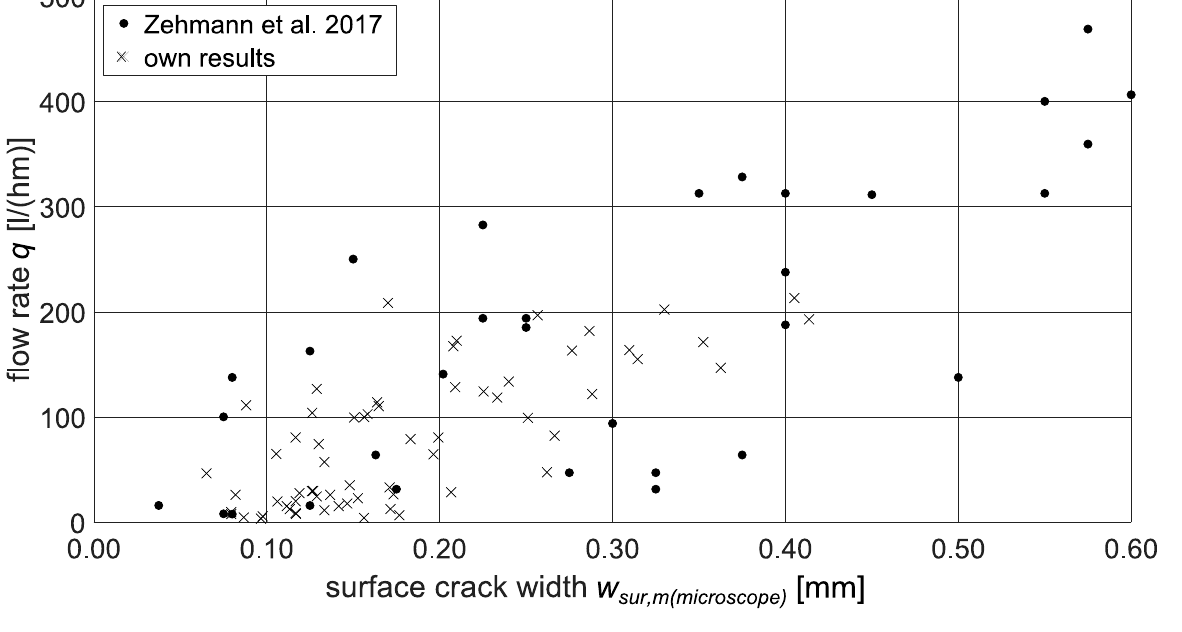
Figure 15. Flow rate q in dependence of mean surface-crack width w sur,m . Comparison of experimentally determined flow rate values to literature [58].